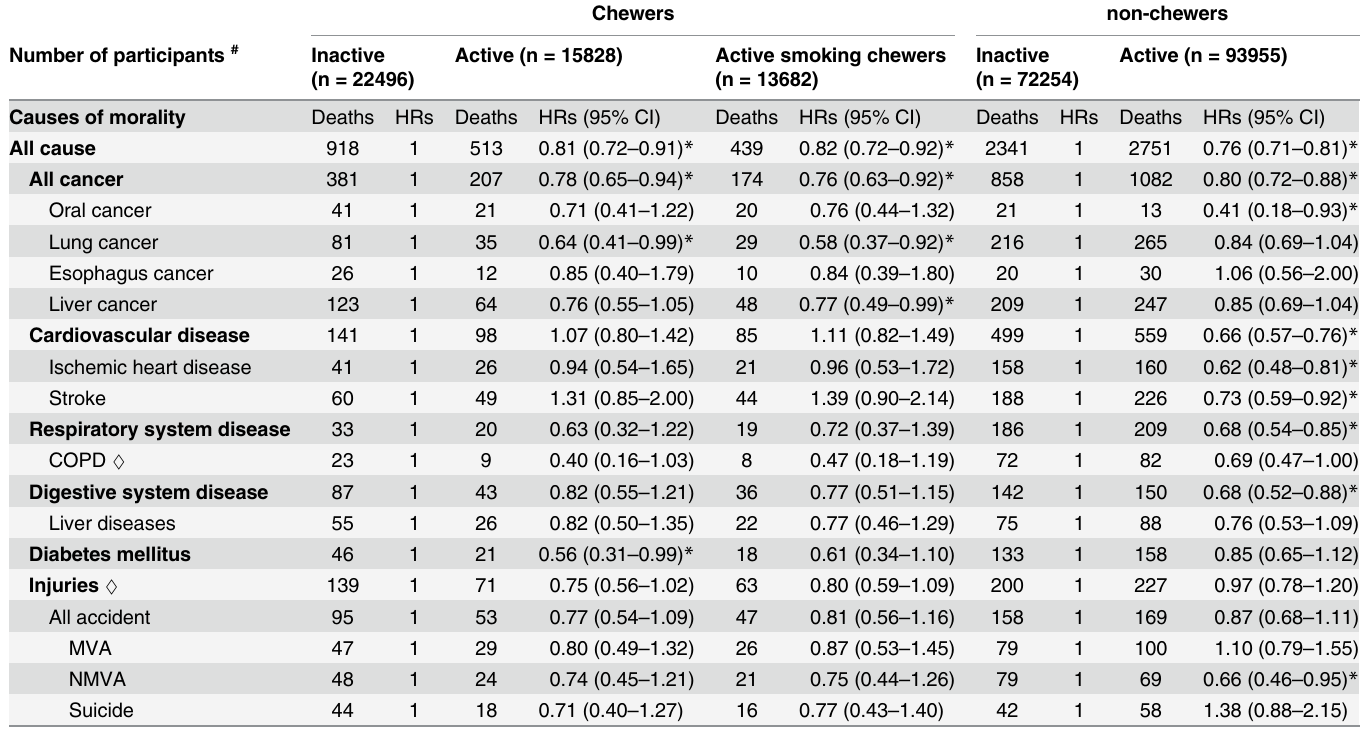
Table 3. Benefits or reduced mortality for chewers and for non- chewers from being